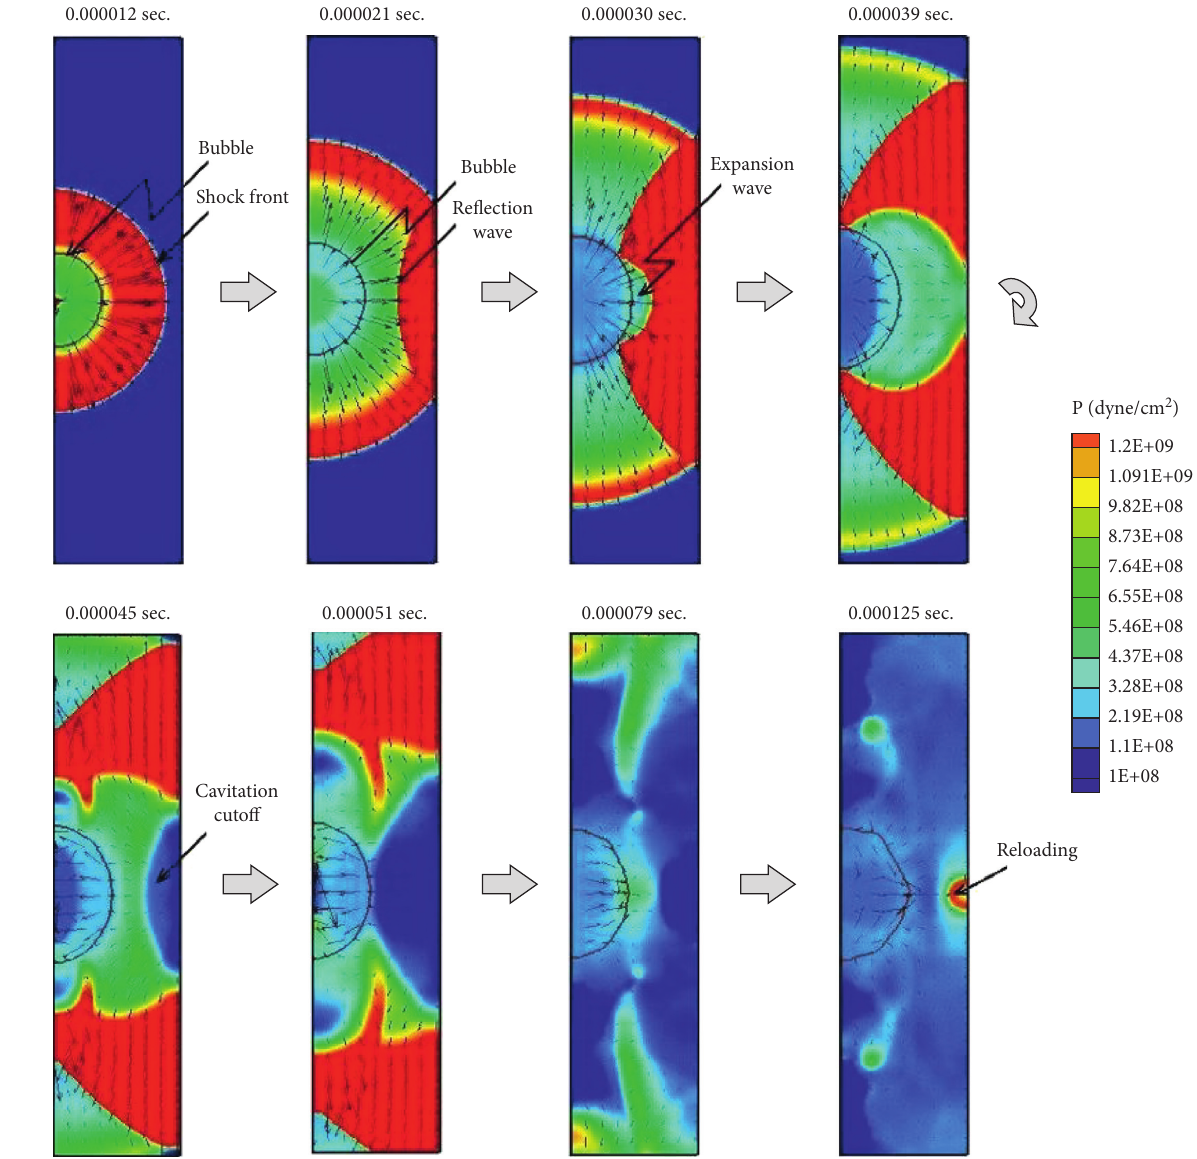
Figure 25: Pressure contours inside the rigid wall tube (2D axisymmetric